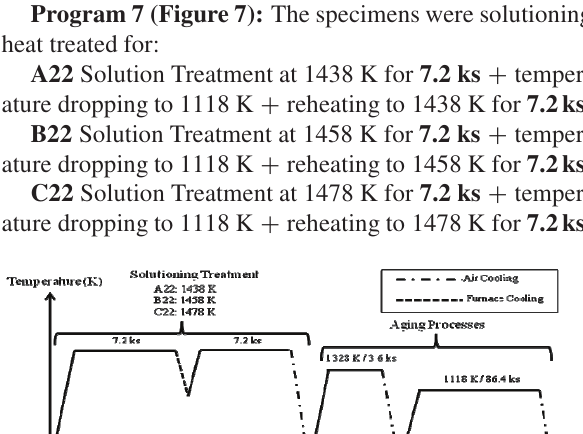
Figure 6. Simulated reheat treatment programs: A13, B13 and C13.